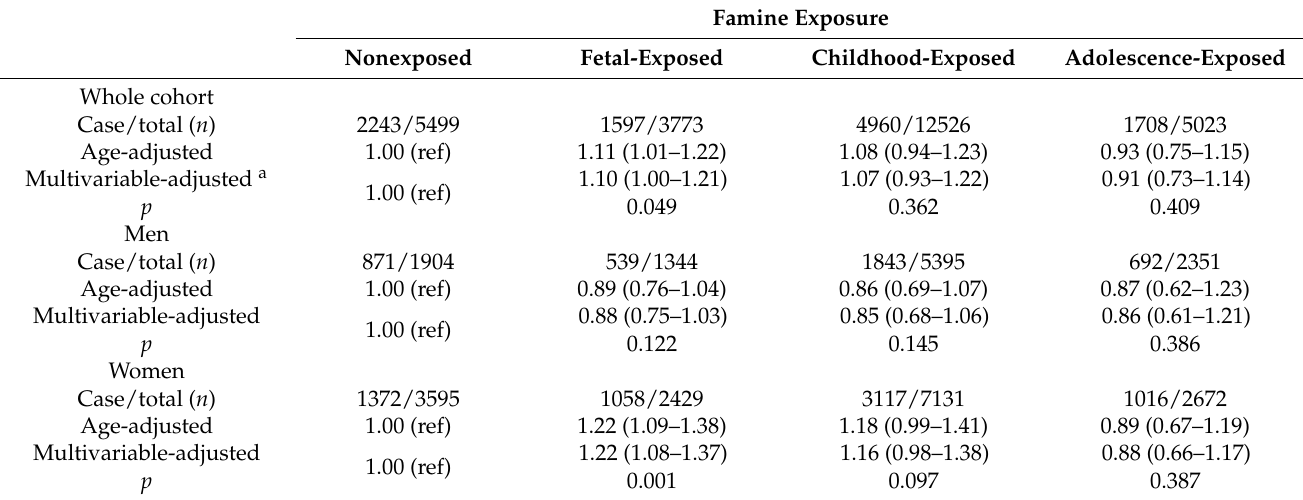
Table 3. ORs (95% CIs) for MAFLD according to famine exposure in early